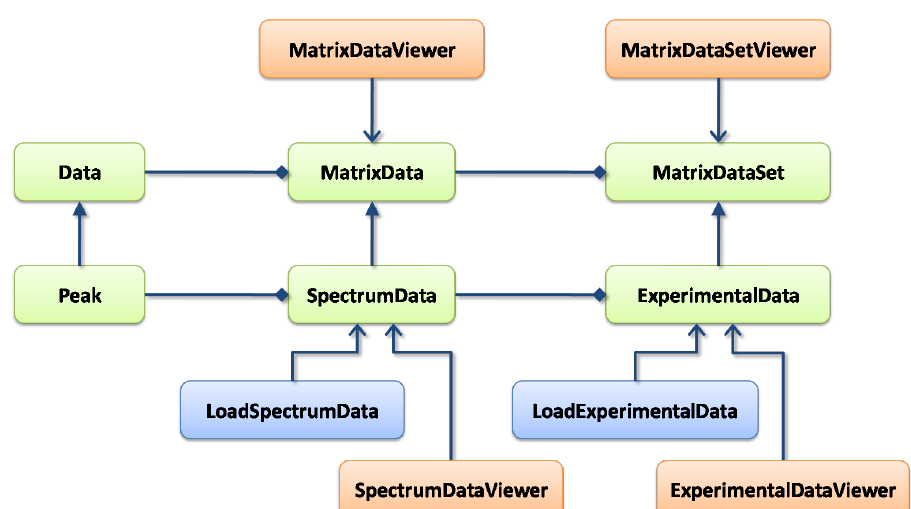
Figure 2: Main data-types (green), operations (blue) and views (orange) of the ’Peptide Analysis’